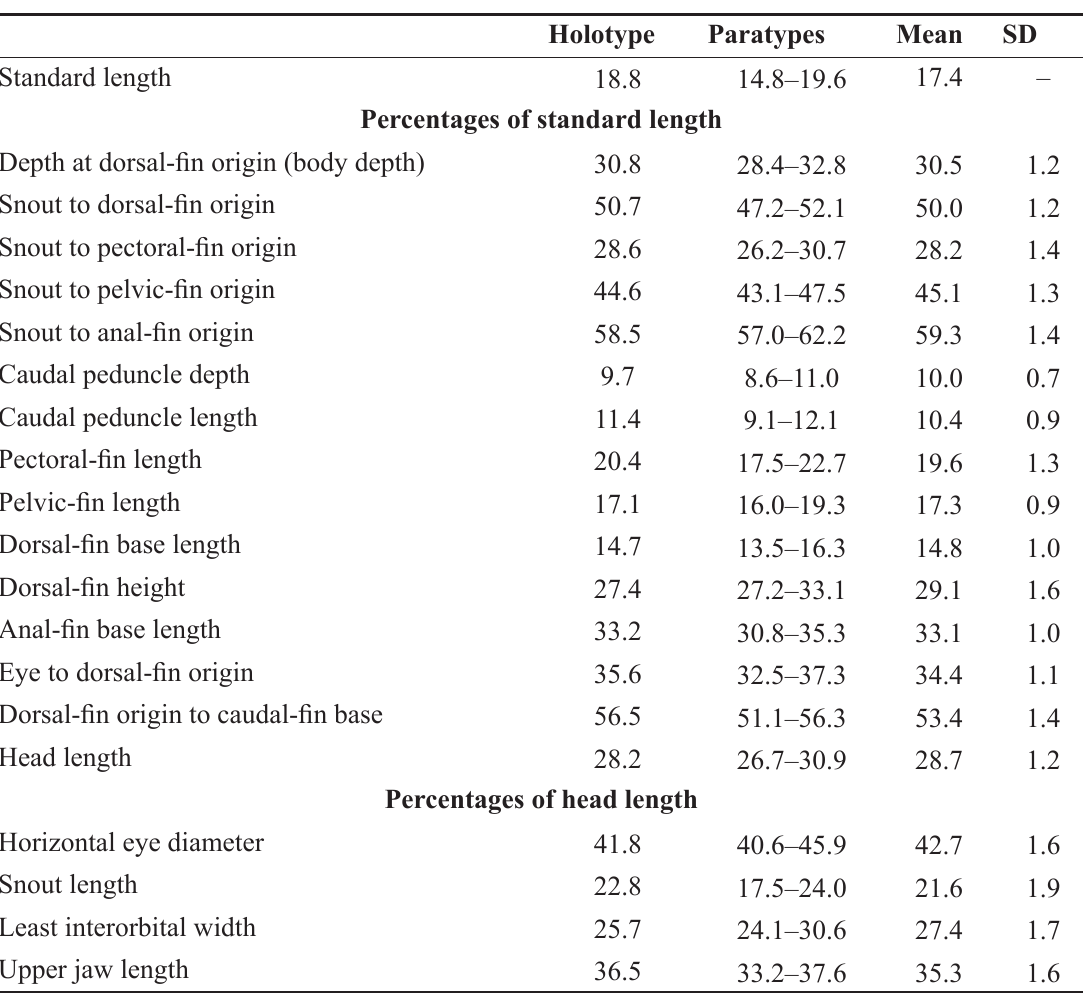
Table 2. Morphometric data (N = 18) for the holotype and paratypes of Hyphessobrycon frickei Guimarães, Brito, Bragança, Katz & Ottoni sp. nov., SD = Standard